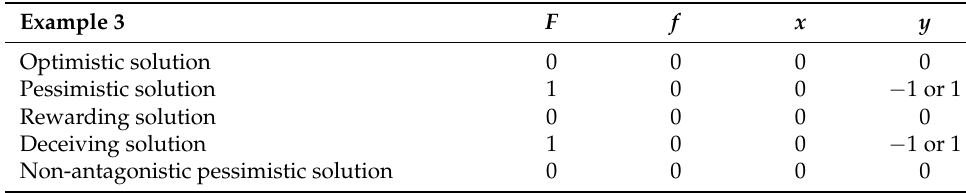
Table 3. The solutions and optimal values of Example